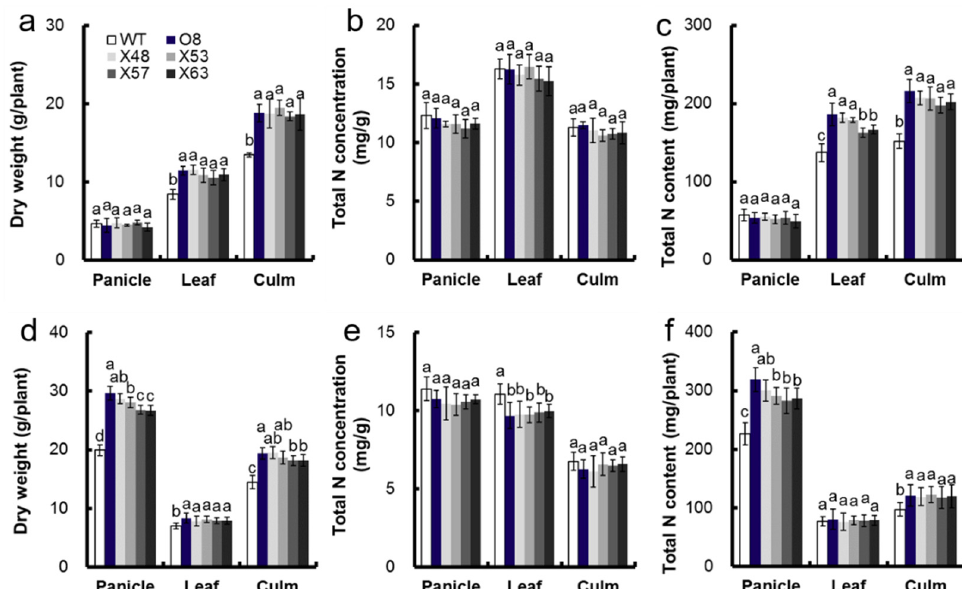
Figure 5. N content in various parts of WT, O8, and EMS mutants. Biomass ( a , d ), N concentration ( b , e ) and N content ( c , f ) in various parts of WT, O8, and EMS mutants at ( a – c ) the anthesis stage and ( d – f ) maturity stage. Error bars: SE ( n = 3 plots). Significant differences between the WT and OsNRT2.3b overexpressing lines are indicated by different letters ( p < 0.05, one-way ANOVA).